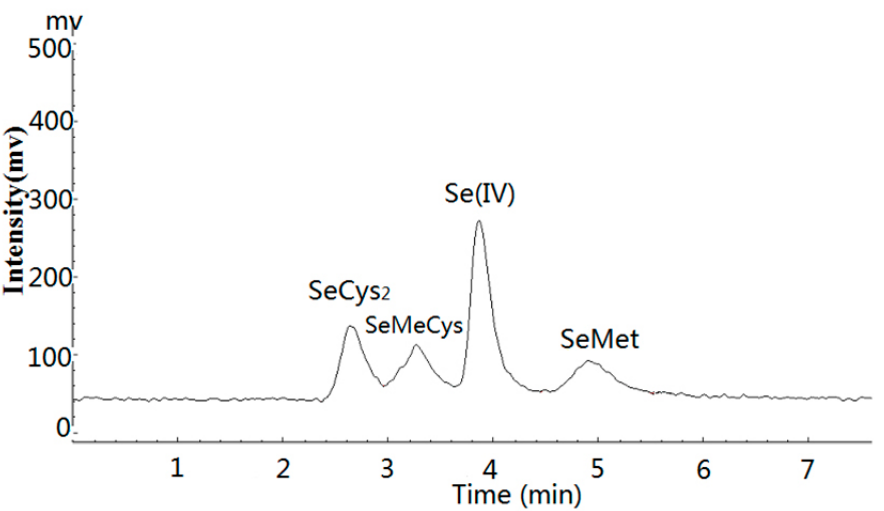
Figure 2. Chromatogram of the four Se standard mixture including SeCys 2 , SeMeCys, Se(IV), and SeMet. Concentrations of the Se standards were 100 μ g/L. Table 2. Optimized instrumental parameters for liquid chromatogram (LC).